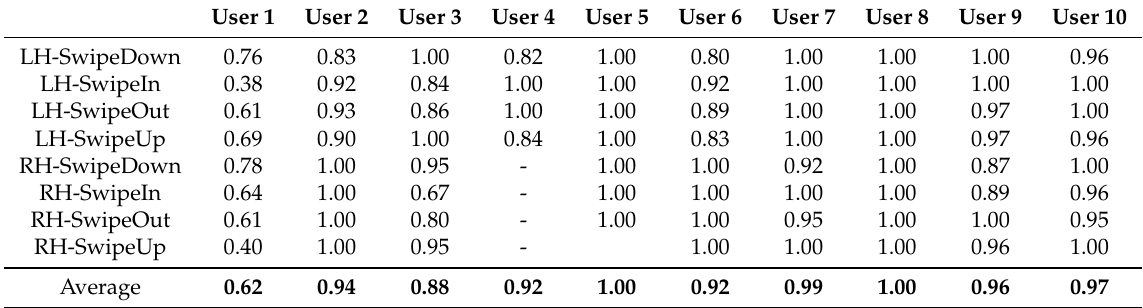
Table 4. F 1 score for each gesture separately and mean F 1 score for all gestures for leave one (user) out